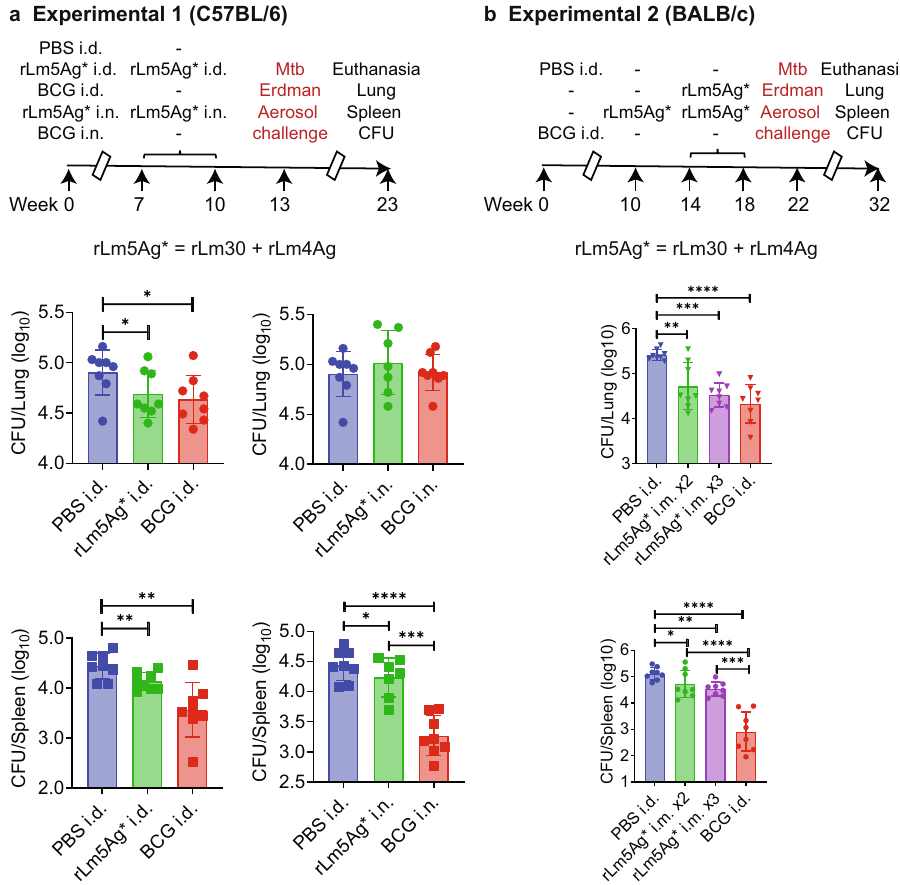
Fig. 6 Ef fi cacy of immunization with rLm vaccines expressing 5 Mtb antigens against Mtb aerosol challenge. a Top Panel: C57BL/6 mice ( n = 8/group) were immunized i.d. with PBS (Sham), i.d. or i.n with BCG at Week 0, or immunized i.d. or i.n. twice at Weeks 7 and 10 with rLm5Ag* (rLm30 + rLm4Ag), challenged at Week 13 with aerosolized Mtb Erdman strain (average of 24 CFU delivered to the lung of each animal, as assayed at Day 1 post challenge) and euthanized at Week 23. Middle and Bottom Panels: Lungs and spleens of mice immunized i.d. (left panels) or i.n. (right panels) were assayed for organ bacterial burden. Shown are means ± SEM. Each symbol represents one mouse. * P < 0.05; ** P < 0.01; *** P < 0.001 and **** P < 0.0001 by 2-tailed non- paired t-test (Prism). b Top Panel: BALB/c mice (8/group) were immunized i.d. with PBS or i.d. with BCG at Week 0, or immunized i.m. twice (x2) at Weeks 14 and 18 or three times (x3) at Weeks 10, 14, and 18 with rLm5Ag*. The mice were then challenged with aerosolized Mtb Erdman strain (average of 30 CFU delivered to lung of each animal, as assayed at Day 1 post challenge) at Week 22 and euthanized at Week 32. Middle and Bottom Panels: Lungs and spleens were assayed for organ bacterial burden. Shown are means ± SEM. Each symbol represents one mouse. * P < 0.05; ** P < 0.01; *** P < 0.001; and **** P < 0.0001 by one-way ANOVA with Tukey ’ s multiple comparisons test (Prism